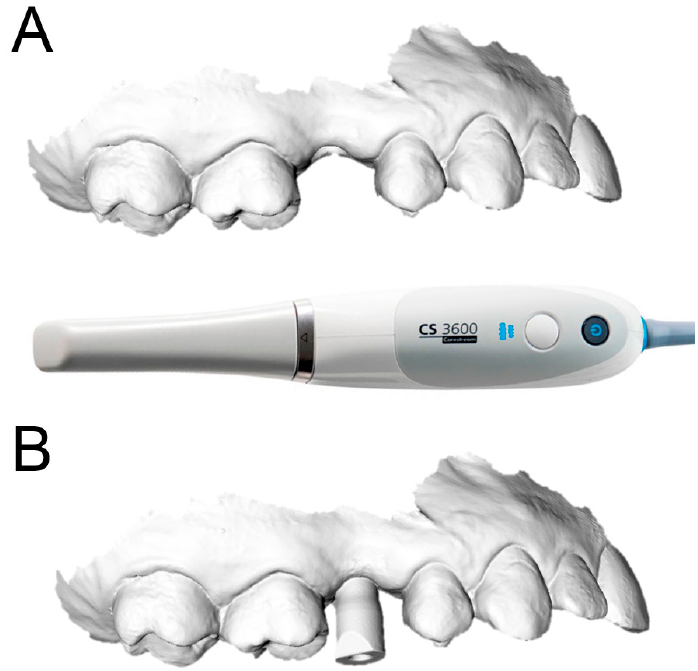
Figure 11. Optical impression with CS 3600 ® (Carestream Dental, Atlanta, GA, USA). ( A ) Without scanbody. ( B ) With scanbody.